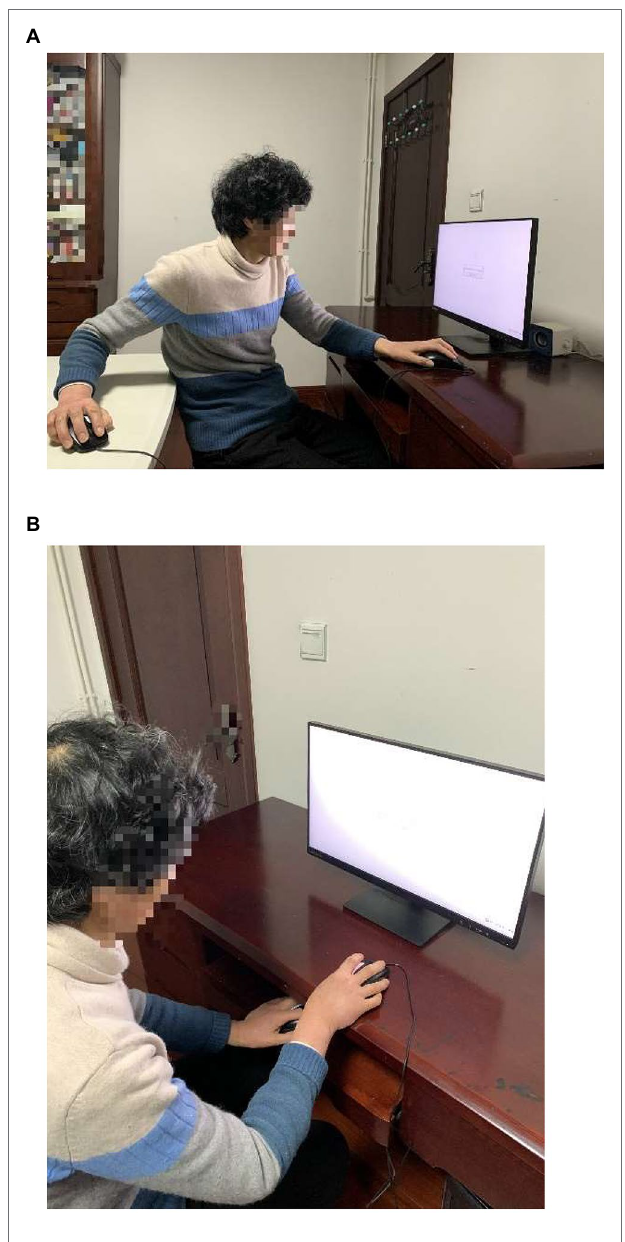
FIGURE 2 | The position of the computer mice when making judgments along the sagittal axis (A) and along the vertical axis (B)